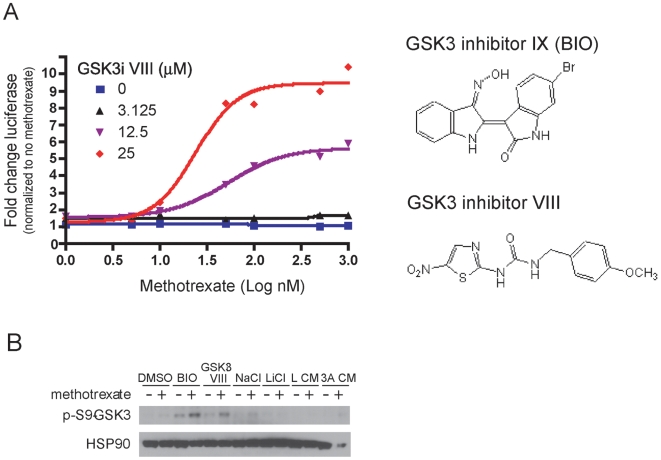
BAR activation induced by dual inhibition of DHFR and GSK3 correlates with increased GSK3β phosphorylation.(A) The experiment was performed as described for BIO in figure legend 2 with the substitution of an alternative GSK3 inhibitor. (B) RKO-BAR cells were exposed to multiple activators of β-catenin signaling (GSK3 specific inhibitors BIO and GSK3i VIII, lithium chloride (LiCL), and Wnt3A conditioned medium (3ACM)) or controls (DMSO, NaCL, and control conditioned medium (LCM)). Protein lysates were harvested and subjected to Western Blot analysis with a GSK3β phospho-serine 9 specific antibody. The enhancement of BAR activity by DHFR inhibition correlated with agents that induced phosphorylation of GSK3 at inhibitory residue serine 9. The result is representative of two separate experiments.